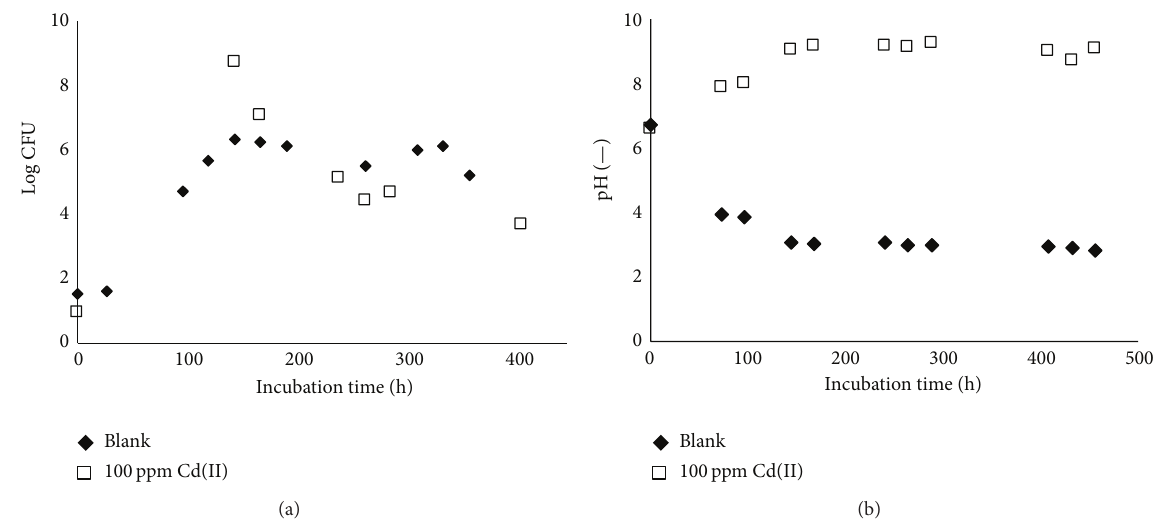
Figure 8: Growth of Aspergillus niger determined by spread plate colony counting (a) and evolution of pH (b) over incubation time in blank potato dextrose broth medium and in the presence of 100ppm Cd(II) (0.9 mM).